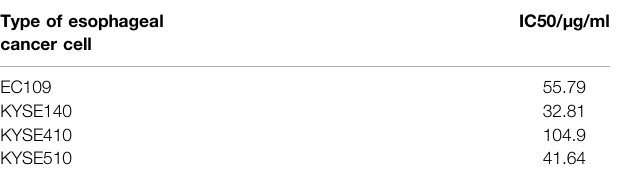
TABLE 8 | The half maximal inhibitory concentrations of OH on the line of esophageal cancer cells.